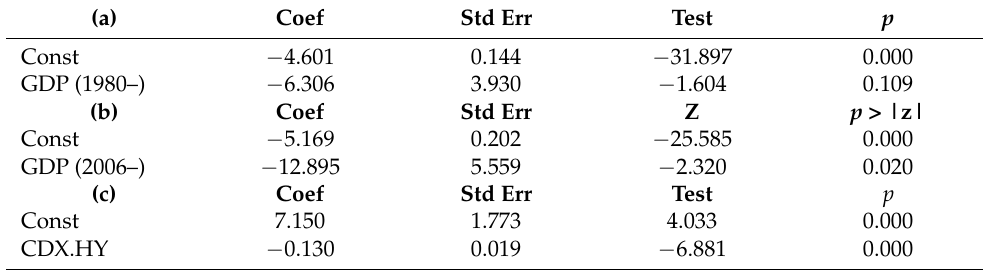
Table 4. Rating Ba: model parameter estimates and p -values.